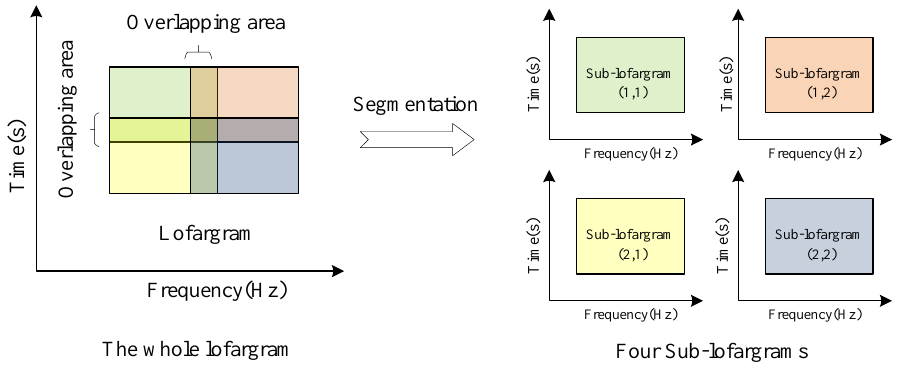
Figure 3. The segmentation of lofargram.